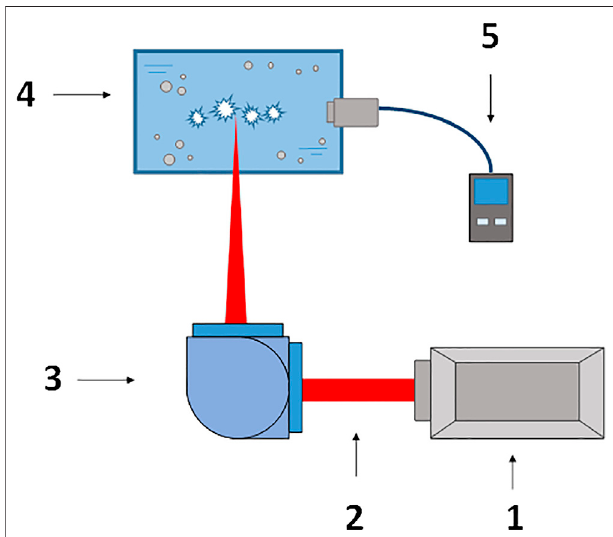
FIGURE 1 | Scheme of the experimental setup. 1) Nd:YAG laser, λ (cid:1) 1,064 nm, τ (cid:1) 100 ns, ν (cid:1) 10 kHz, 2) Laser radiation, 3) Motorized system of re fl ecting mirrors and lenses, 4) Cuvette with an aqueous solution of nanoparticles, 5) H 2 and O 2